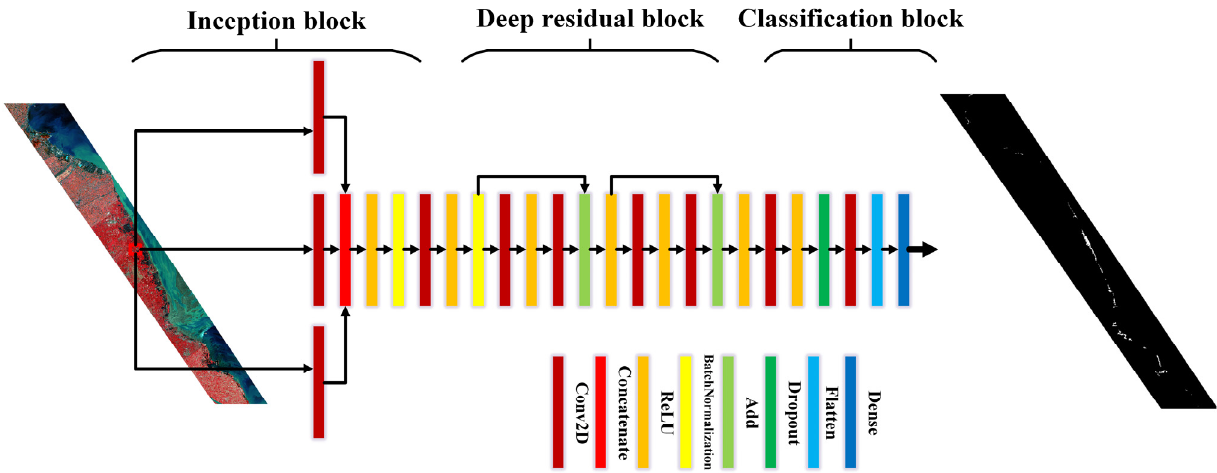
Figure 4. Overall construction of proposed multi-scale residual convolutional neural network (MRCNN).